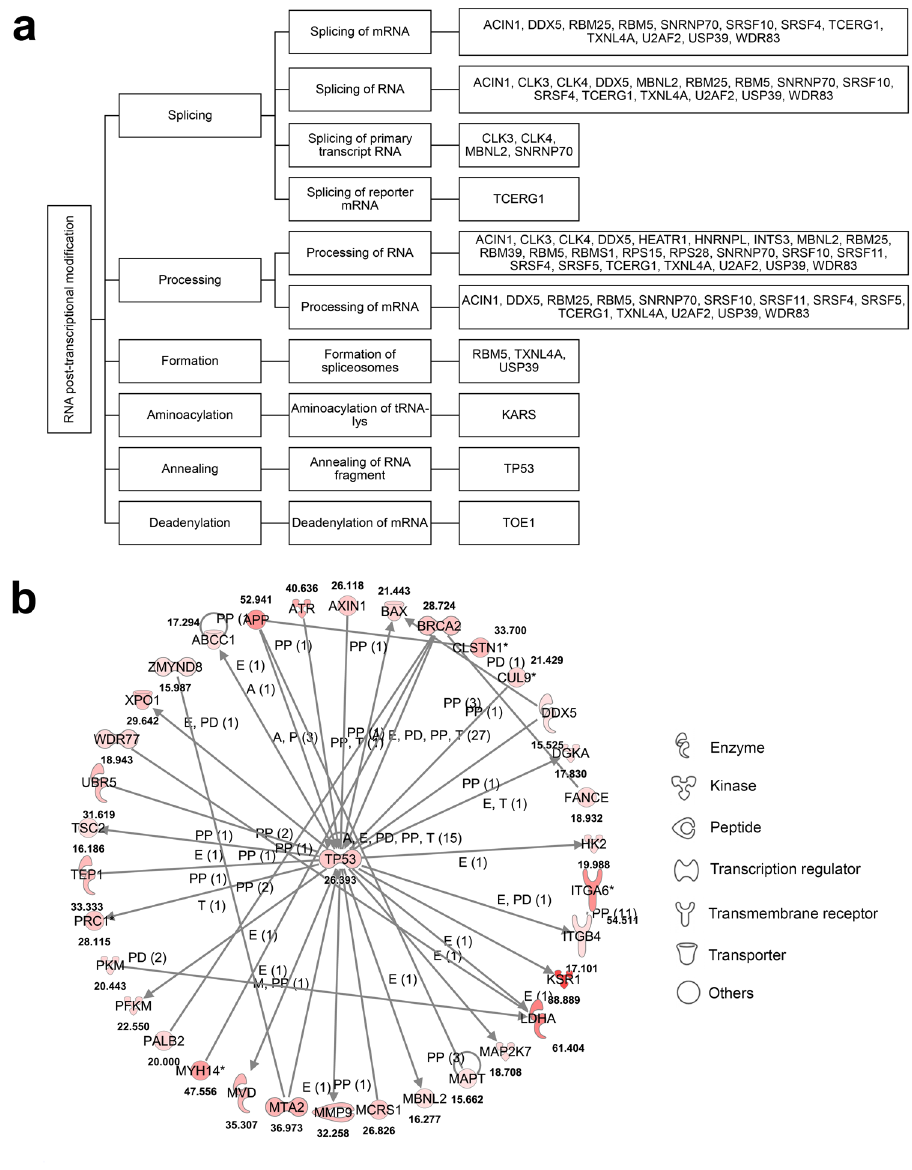
Figure 3. Hypoxia-regulated intron retention targets are involved in RNA post-transcriptional modification and cancer function. ( a ) Tree diagram showing functional distribution of chronic hypoxia-regulated genes with significantly upregulated intron retention events (FDR < 0.01 and | Δ SI| ≥ 15%) that are involved in RNA post- transcriptional modification processes. ( b ) Network of hypoxia-regulated genes with significantly up-regulated intron retention events involved in cancer function. The network was generated using IPA with the criteria that only experimentally observed, direct relationships in human were used. Numbers indicate the Δ SI for each gene. The types of relationships include expression (E), protein-protein interactions (PP), activation (A), transcription (T), protein-DNA interactions (PD) and modifications